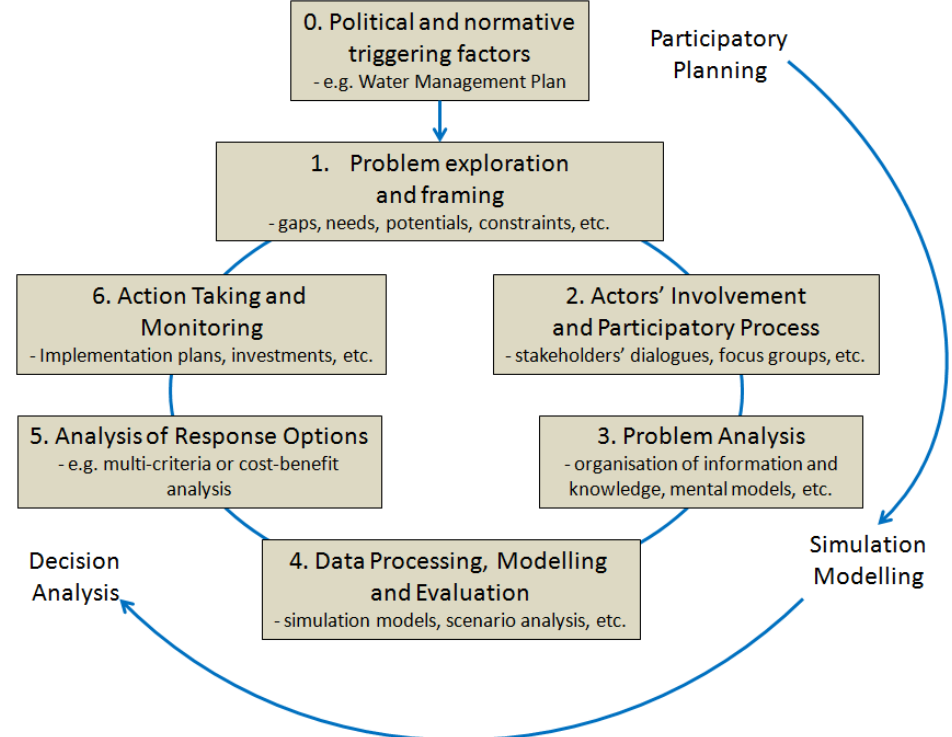
Figure 1. A generic decision/policy-making process , with its main steps and the areas of influence of participatory planning, simulation modelling and decision